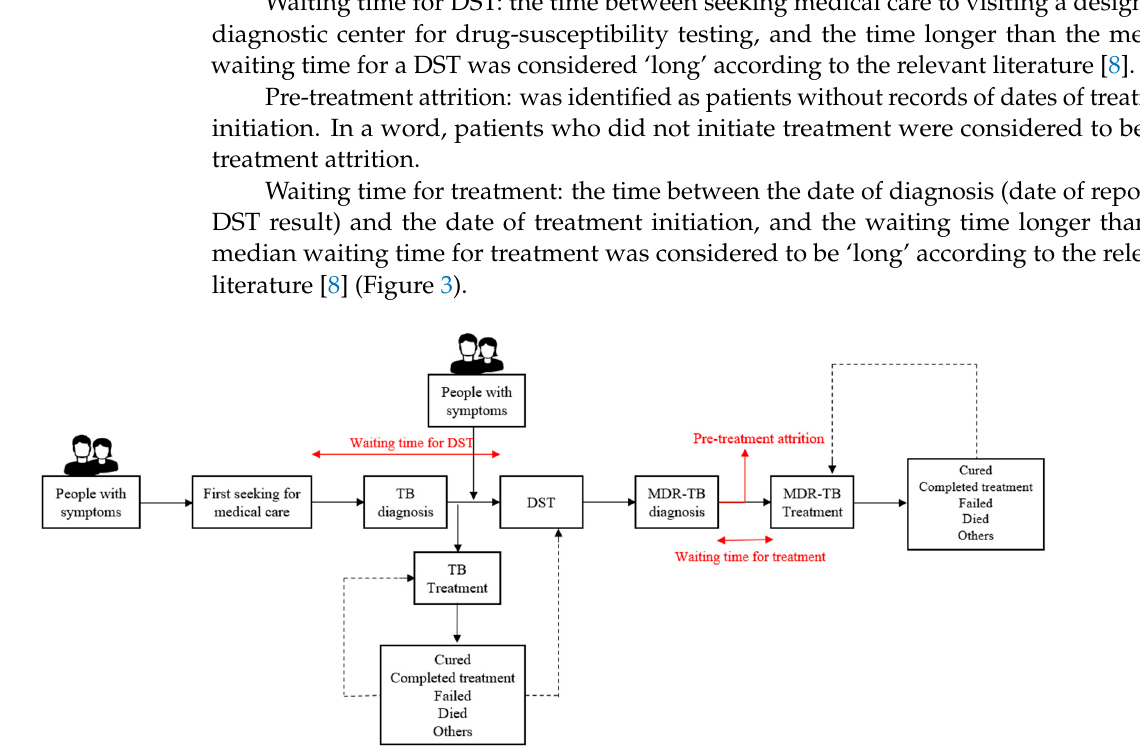
Figure 3. The diagnosis and treatment pathway for MDR/RR-TB patients and definitions used in the study.